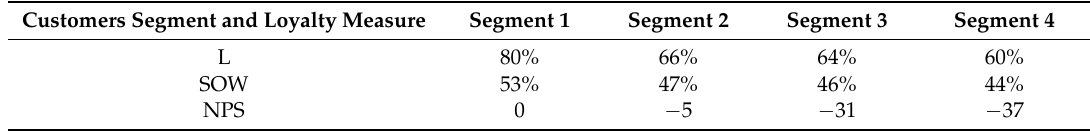
Table 2. Loyalty measures for each segment of the